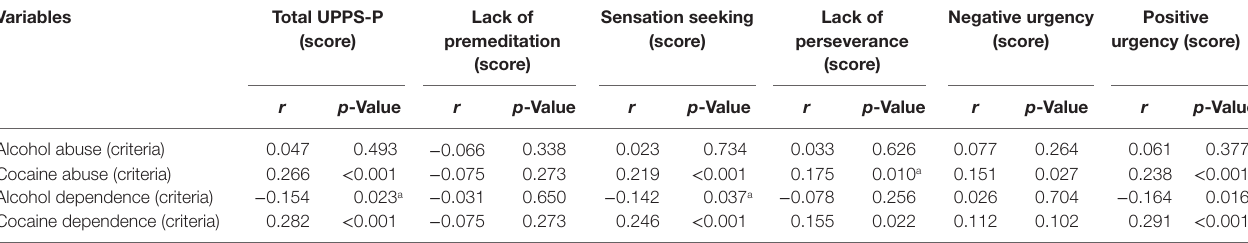
Table 4 | Correlation between criteria for substance use disorders and impulsivity subscales (UPPS-P). Variables